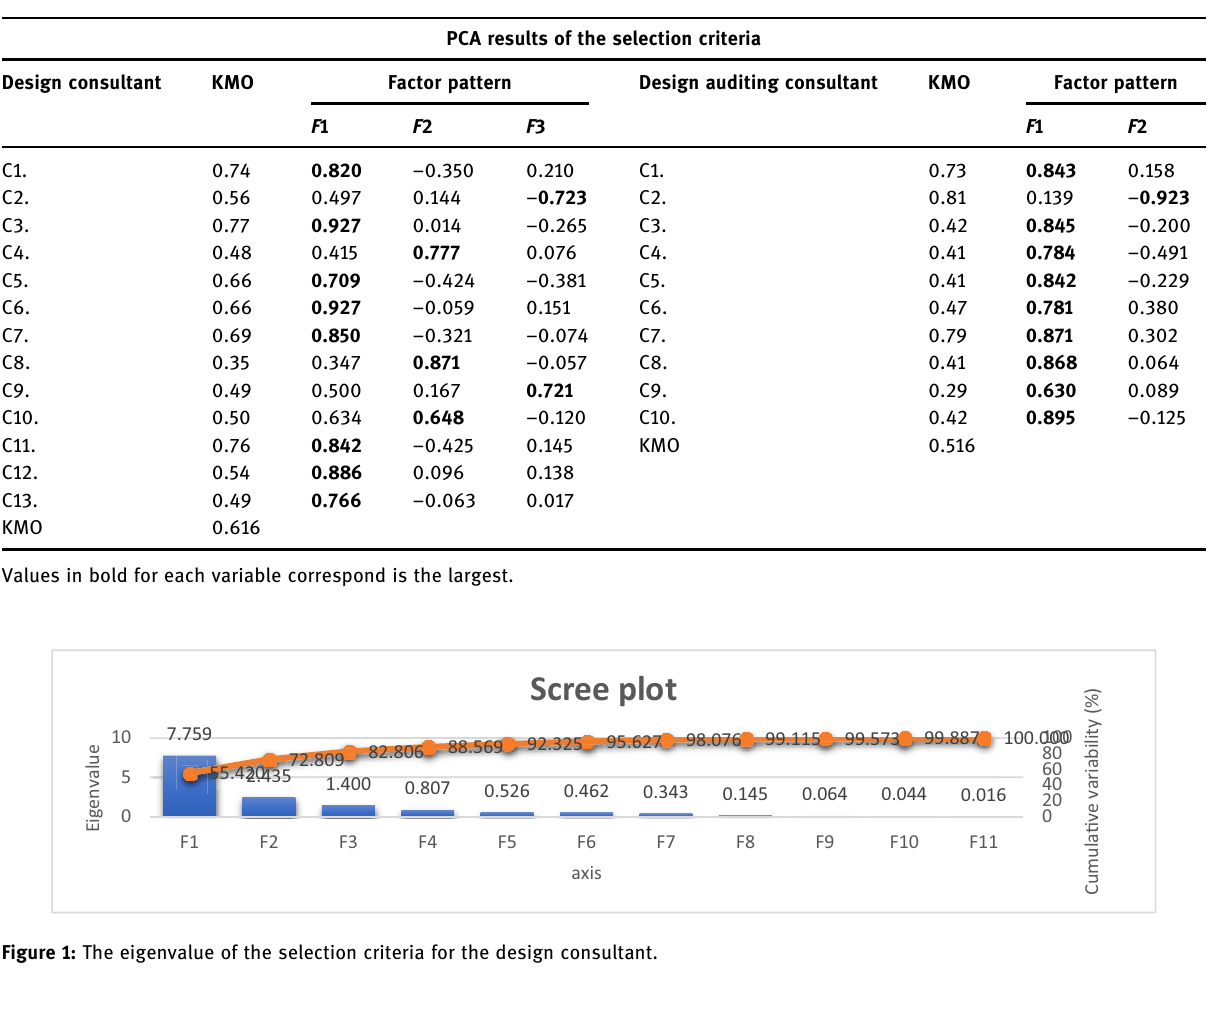
Table 6: The KMO and PCA factor pattern values of the selection criteria for the design consultant and the design auditing consultant